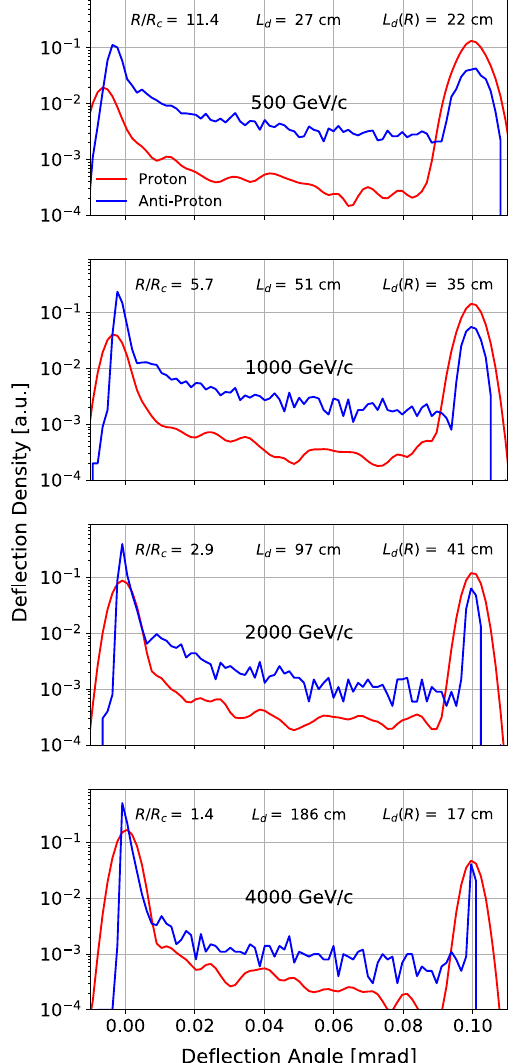
units) as μ = Jg μ B s and δ = Jd μ B s , respectively, where = e ¯ h /( 2 mc ) is the particle magneton. μ B